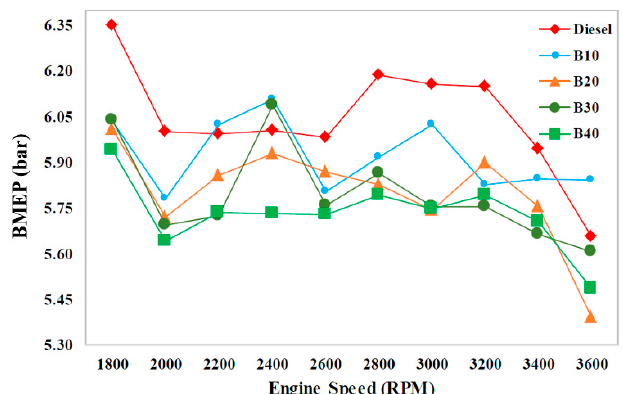
Figure 15. The brake mean effective pressure (BMEP) of the different fuel types against the engine speed.